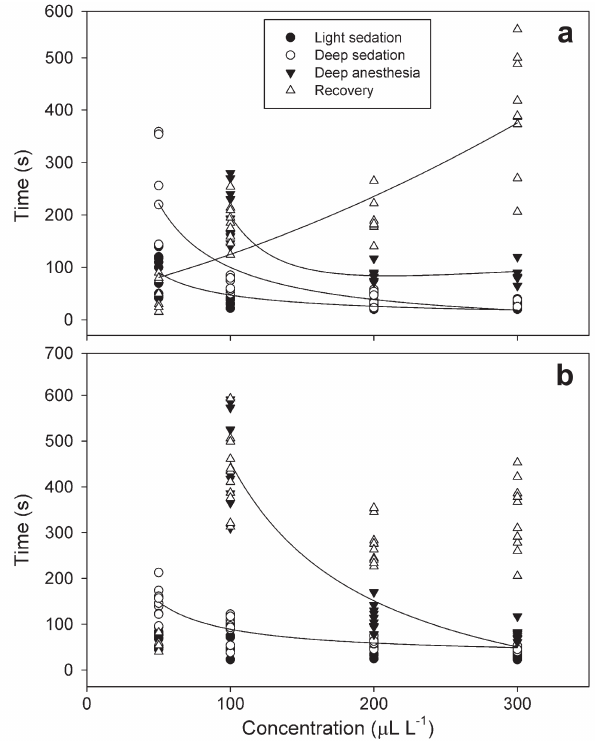
Fig. 2. Relationships concentration x anesthesia induction or recovery time in tambaqui, Colossoma macropomum , exposed to the linalools. a. synthetic linalool; light sedation: y=4.4+(4281/x), r 2 =0.716, deep sedation: y=-22.5+(12252/x), r 2 =0.773, deep anesthesia: y=15.3+(17878/x), r 2 =0.669, recovery: y=43.9+0.66x+0.0015x 2 , r 2 =0.712. b. linalool extracted from Aniba rosaeodora ; deep sedation: y=29.0+(6010/x), r 2 =0.784, deep anesthesia: y=-151.3+(60541/x), r 2 =0.873. Light sedation and recovery: no significant relationship. y = time to reach stage or recovery (s) and x = concentration (µL L -1 ). Tab. 1. Time required for induction and recovery from anesthesia using the essential oils of Aniba rosaeodora (EOAR) and Aniba parviflora (EOAP). Different letters in the column indicate significant difference between concentrations. One- way ANOVA and Tukey’s test (P<0.05). Stages in which there was a significant relationship concentration x time of anesthesia induction, no statistical comparison between concentrations was